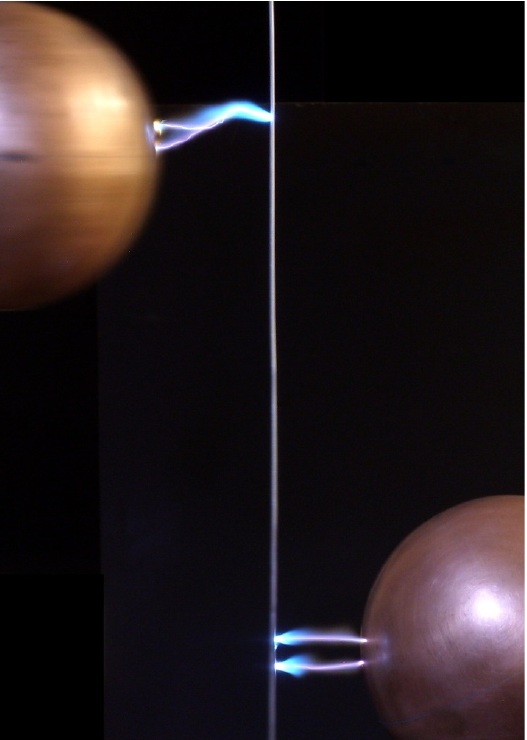
Figure 17. A branched case of bidirectional simulated lightning strike over an aluminum antenna wire (8 s exposure).